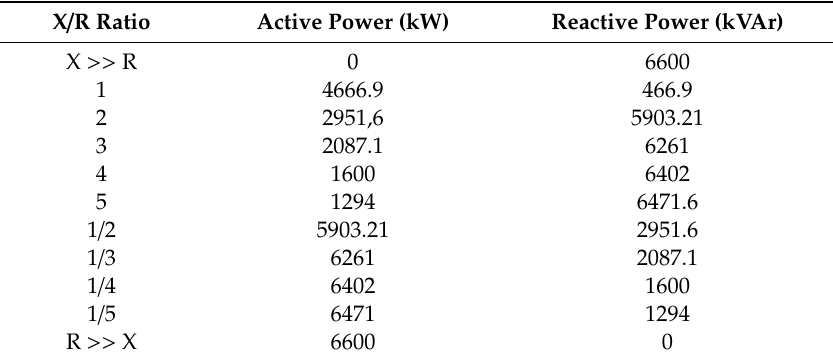
Table 1. Active and reactive power values based on the X / R